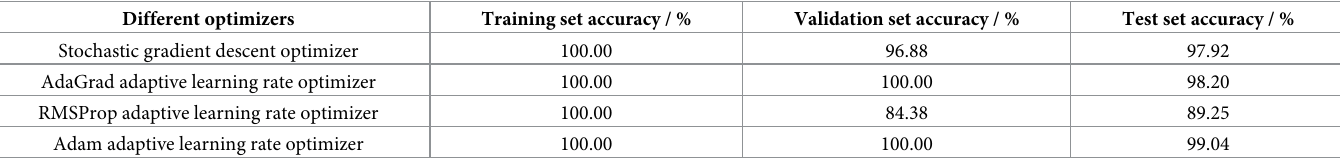
Table 4. Comparison of model accuracy rates under different gradient descent optimizers. Different